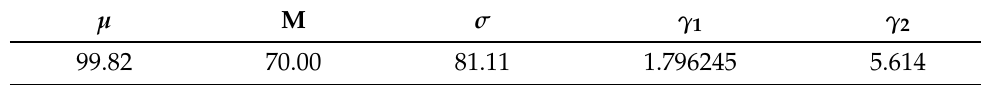
Table 4. Descriptive statistics of the survival times of guinea pigs.